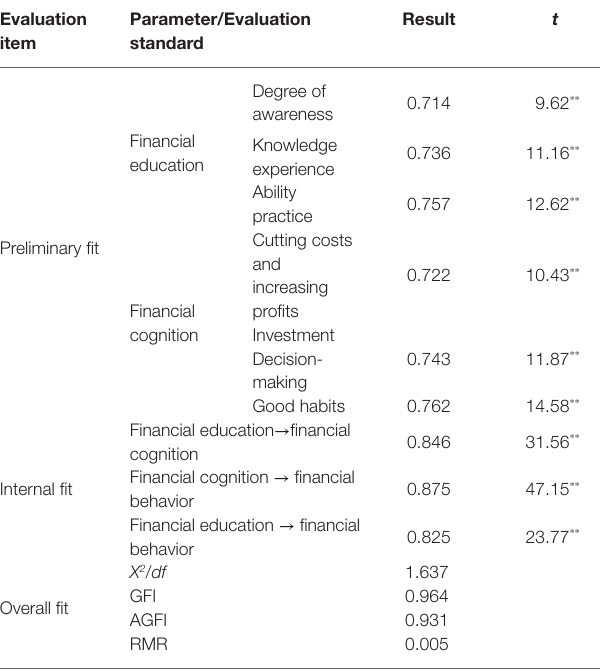
TABLE 1 | Linear structural model